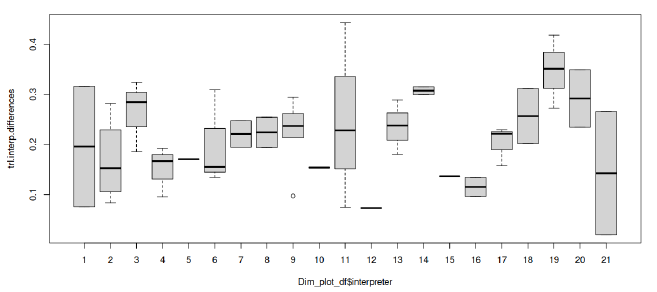
Figure A2. Differences between Dimension 1 scores for interpretations and translations per inter-